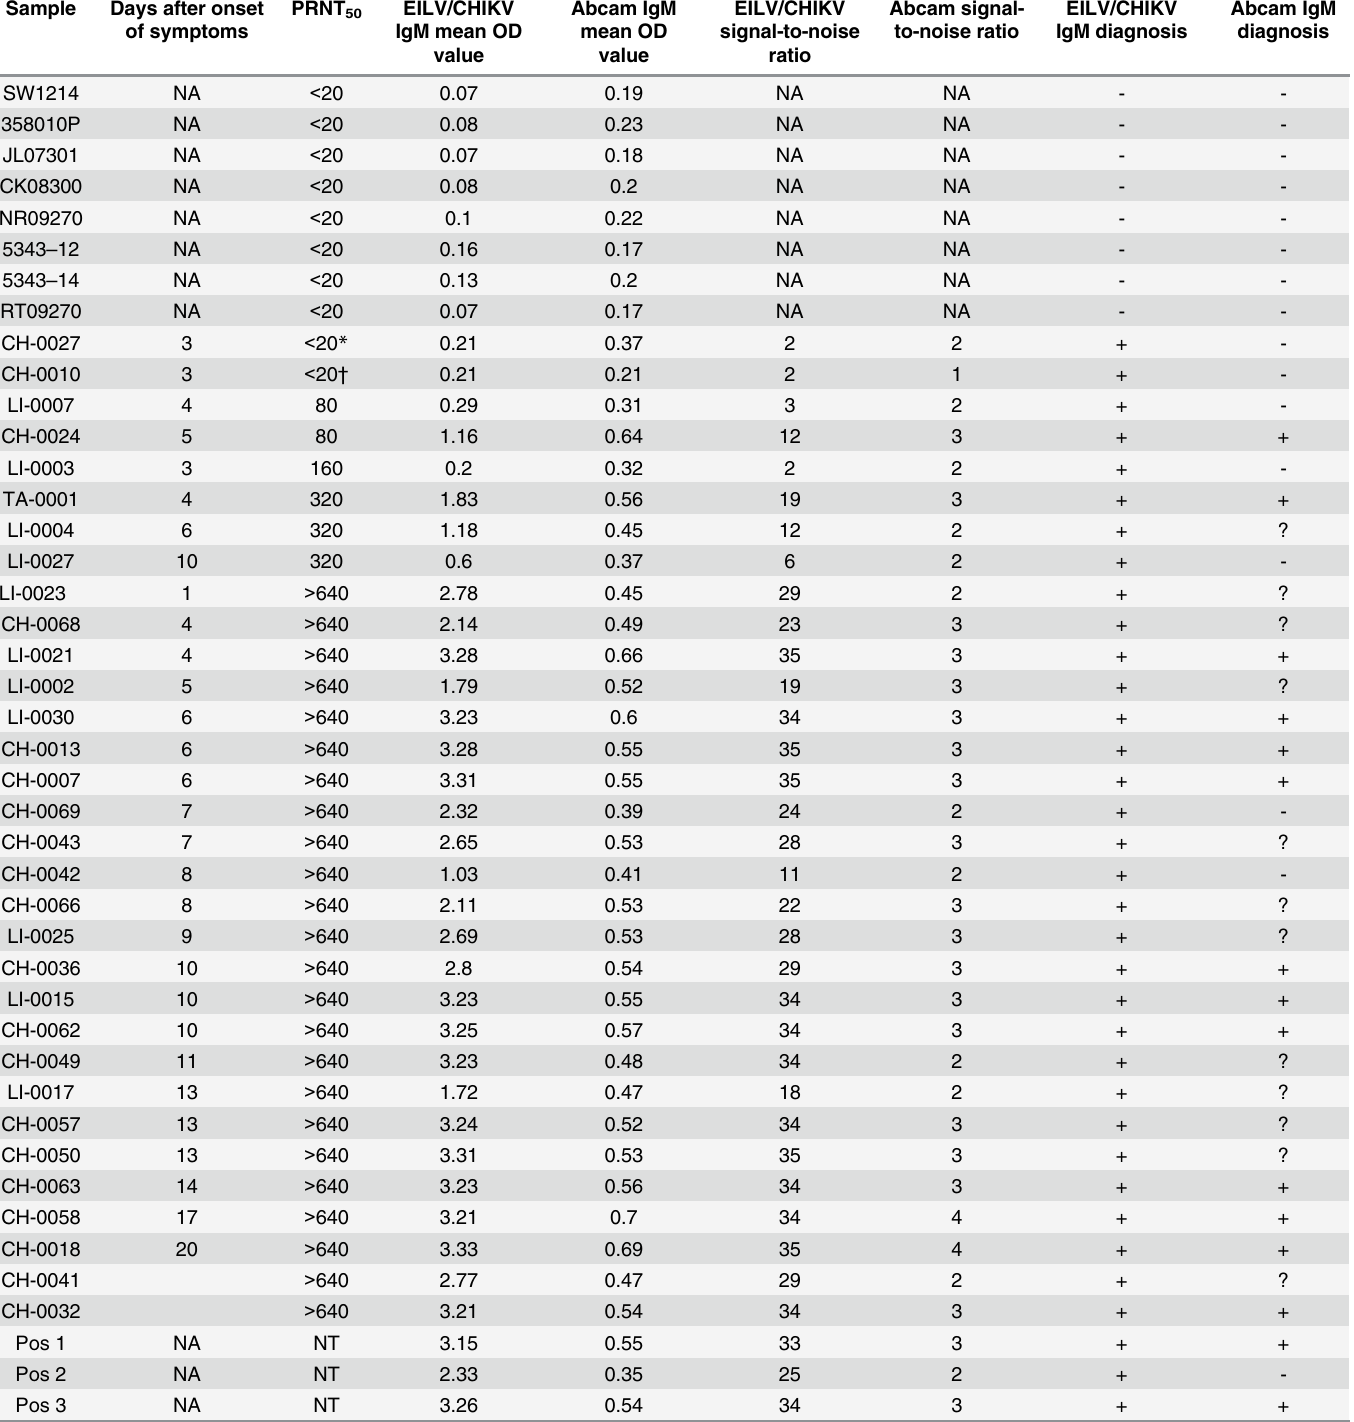
Table 1. Comparative IgM ELISA results using EILV/CHIKV and Abcam